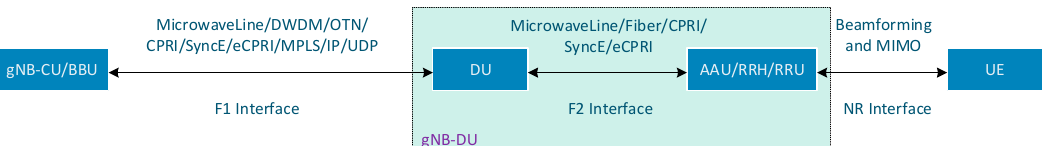
Figure 5. Example of flexible all-optical network connecting the integrated optical gNB-DU/RRH (with massive-MIMO functions) and O-gNB devices to gNB-CU/BBU/EPC/NGC cloud (presented in proceedings [23]).